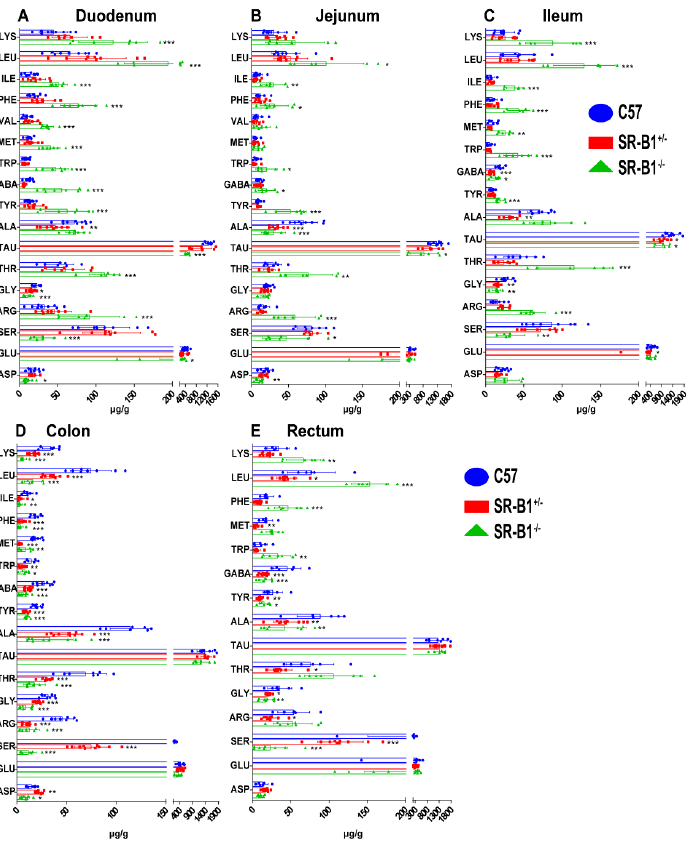
Figure 5. The di ff erence in amino acid contents among SR − B1 − / − , SR − B1 +/ − , and C57 mice ( n = 6–10). Determination of the amino acid contents in the duodenum ( A ), jejunum ( B ), ileum ( C ), colon ( D ), and rectum ( E ) of the C57, SR − B1 +/ − , and SR − B1 − / − mice. The data are presented as the means ± SD; * p < 0.05, ** p < 0.01, and *** p < 0.001 compared with the C57 mice. LYS (lysine), LEU (leucine), ILE (l − isoleucine), PHE (phenylalanine), VAL (valine), MET (DL − methionine), TRP (tryptophan), GABA ( γ− aminobutyric acid), TYR (tyrosine), ALA (alanine), TAU (taurine), THR (L − threonine), GLY (gly ‐ cine), ARG (arginine), SER (serine), GLU (glutamic acid), and ASP (aspartic acid). 2.4. Scavenger Receptor Class B Type 1 Deficiency Influences the Neurotransmitter Contents in the Intestine Compared with those in the C57 mice, the levels of 5 − hydroxyindoleacetic acid (HIAA), 5 − hydroxytryptophan (HTP), 5 − hydroxytryptamine (5 − HT), homovanillic acid (HVA), and 3,4 − dihydroxyphenylacetic acid (DOPAC) in the duodenum of the SR − B1 − / − mice were significantly increased ( p < 0.01). Compared with those in the C57 mice, the HIAA, HTP, 5 − HT, and DOPAC levels in the jejunum of the SR − B1 − / − mice were obviously increased ( p < 0.05), and the HIAA and HTP levels in the ileum of the SR − B1 − / − mice were significantly increased ( p < 0.05). The HIAA, DOPAC, and DA levels in the colon of the SR − B1 − / − mice were significantly reduced ( p < 0.05), while the level of HVA was signifi ‐ cantly increased ( p < 0.05). The levels of adrenaline (E), 5 − HT, and HVA in the rectum of